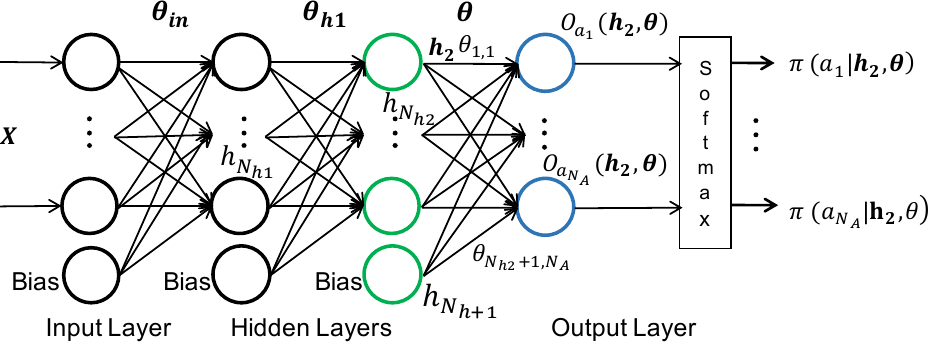
Figure 5. NN architecture used in this paper for activity recognition and online